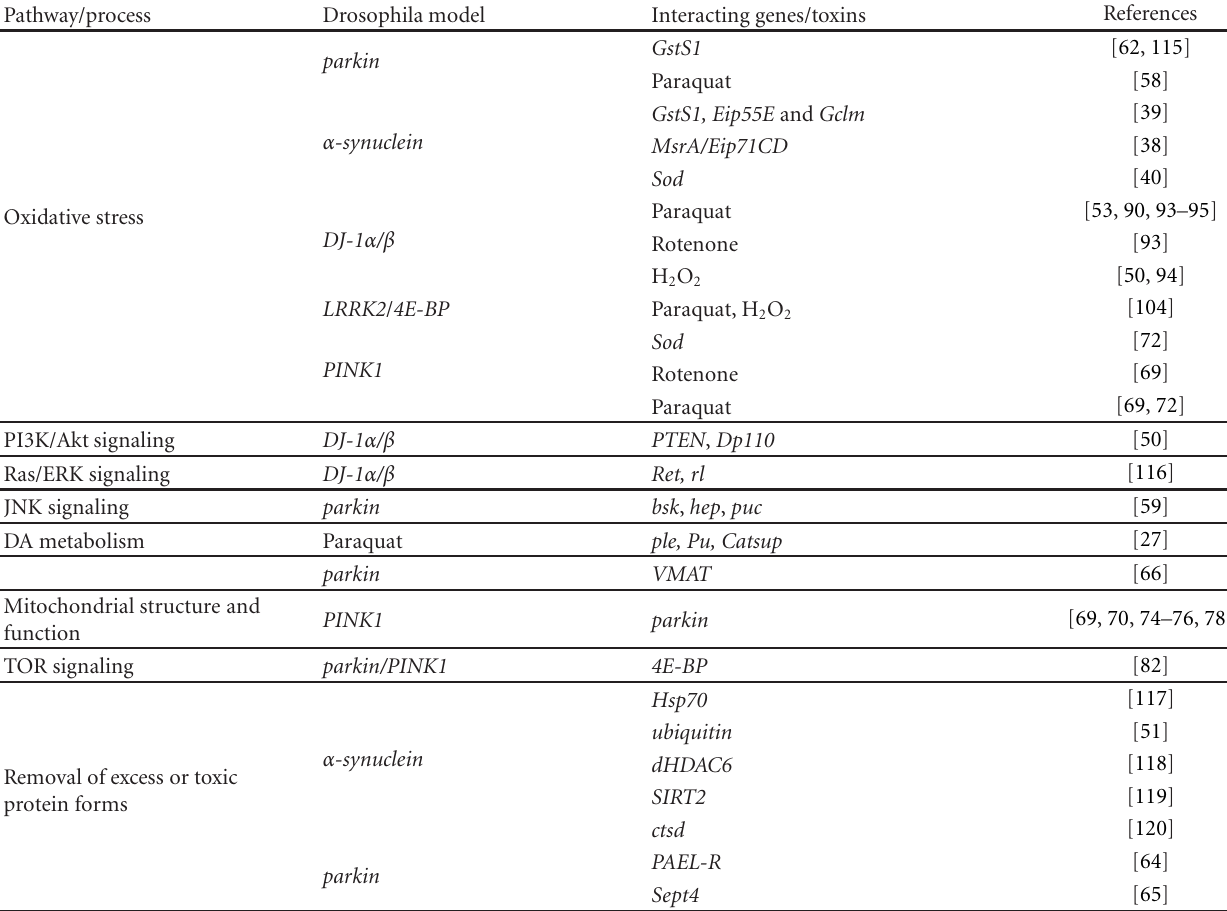
Table 1: Signaling pathways and molecular processes involved in PD pathogenesis that have been identified by using Drosophila PD